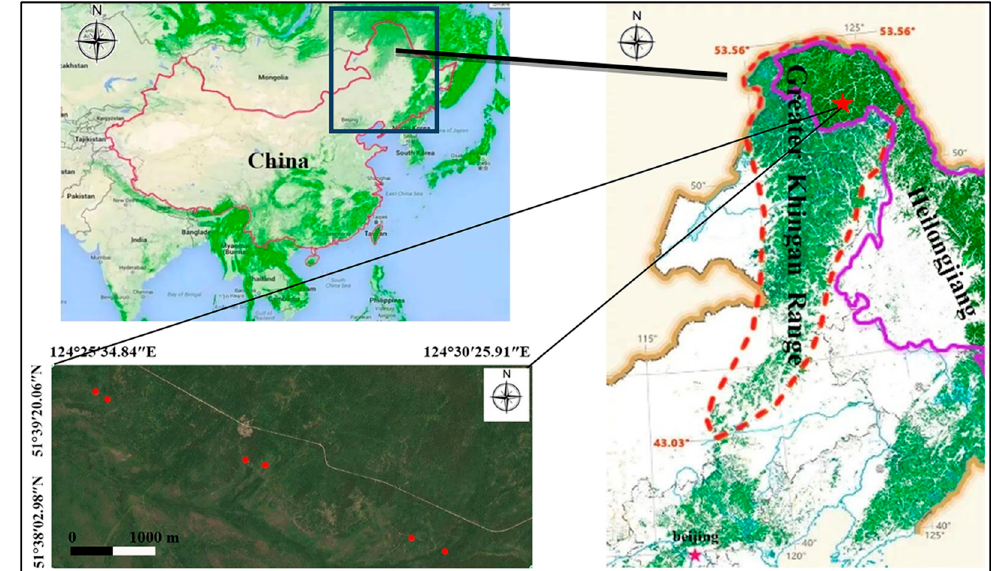
Figure 1. Geographic location of the study area in different thinning intensities in the Greater Khingan Range. (Note: The red dot in the figure is thinning sample plot).